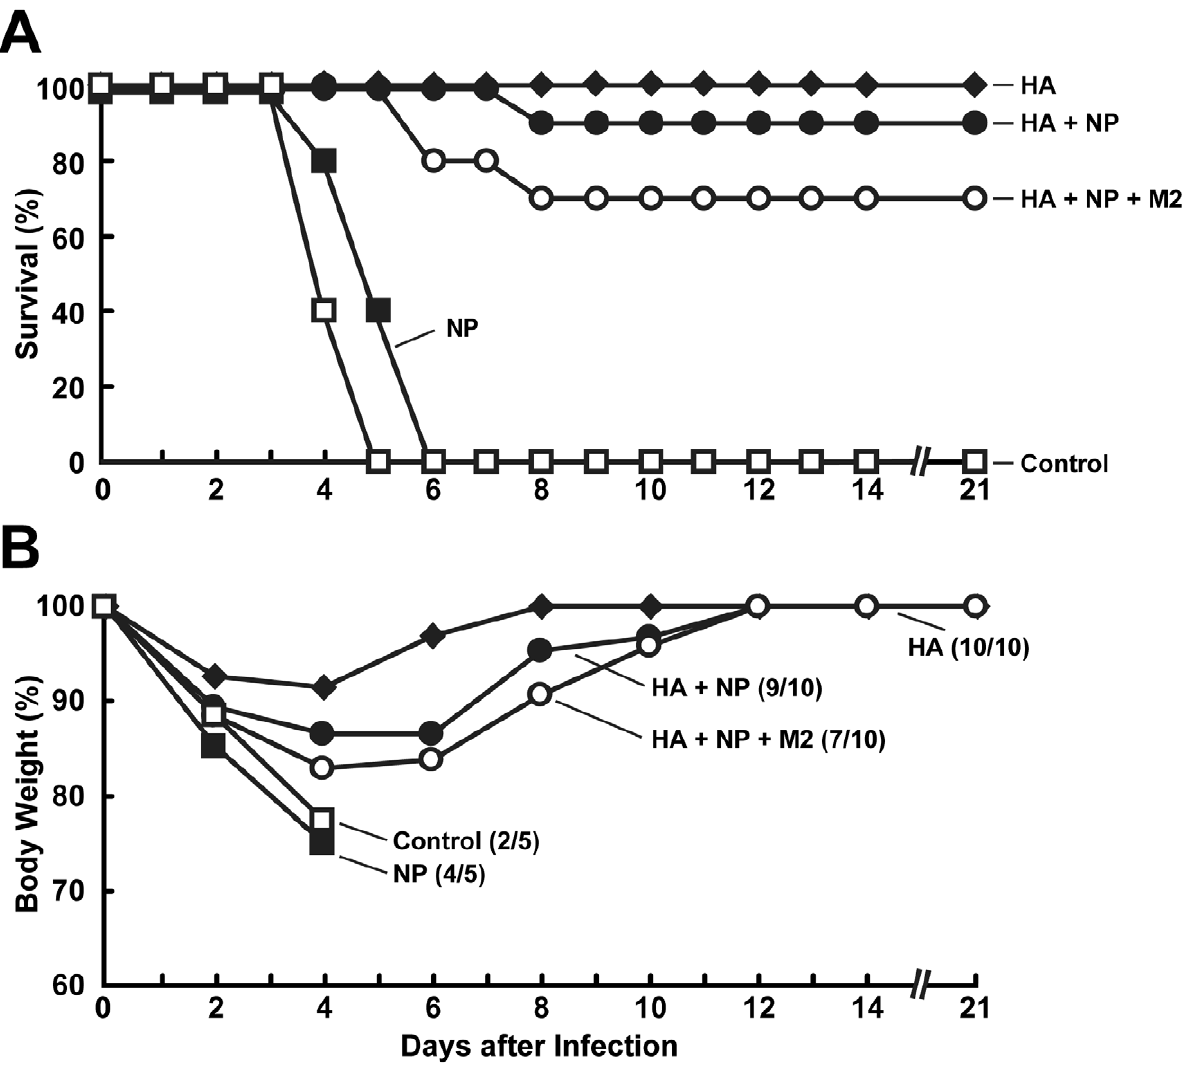
Figure 3. DNA immunization with HA, HA + NP, and HA + NP + M2 induces similar protection after A/Vietnam/1203/2004 virus challenge in mice. (A) Survival data is shown as a percentage comparing the final animal number at day 21 with the initial animal number in each group. All HA-containing groups showed significant survival compared to controls. There is no statistical difference between the HA, HA + NP and HA + NP + M2 groups ( p =0.317 between HA and HA + NP; p =0.146 between HA and HA + NP + M2; p =0.515 between HA + NP and HA + NP + M2 by log- rank test); NP and the control groups were not statistically different from each other. (B) Body weights of the mice were also monitored and the total body weight of all of the surviving animals in each group was compared with the respective initial body weights. As expected, the HA group showed the least amount of body weight loss, with the other HA-containing groups showing similar patterns. However, the NP-immunized group demonstrated severe weight loss, similar to